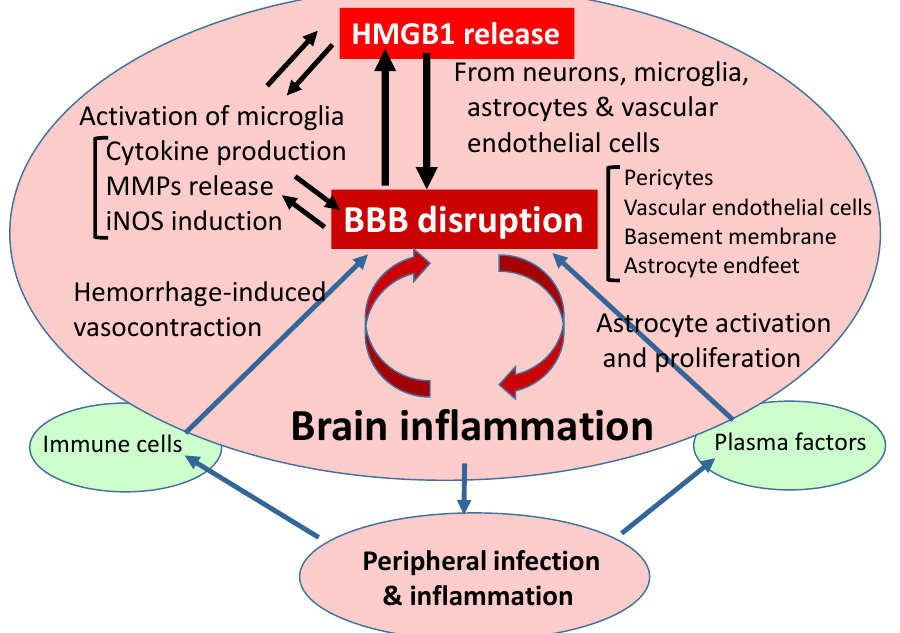
Figure 5. Flow diagram of relationship between HMGB1 release and BBB disruption. As described in the text, HMGB1 release is common to different kinds of injuries induced by ischemia / reperfusion, hemorrhage, trauma, and epilepsy, leading to BBB disruption through direct and indirect pathways. The peripheral inflammation caused by infection may exacerbate BBB disruption. Conversely, brain injuries may induce a vulnerability to infection in patients. BBB: blood–brain barrier; HMGB1: high mobility group box-1; iNOS: inducible nitric oxide synthase; MMPs: matrix metallo proteinases.